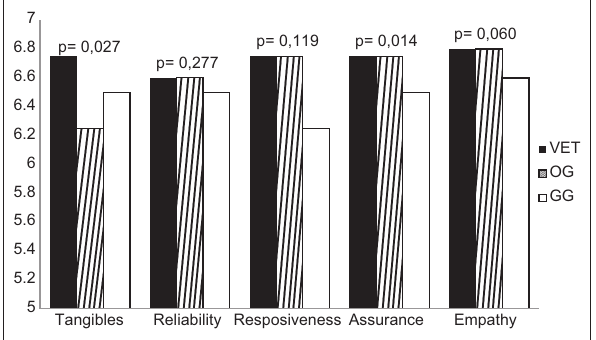
Figure-2: Expectation scores by dimension and